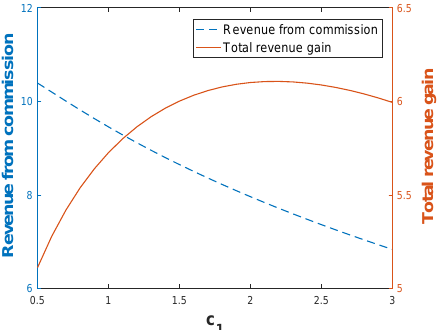
− π 0 . Revenue from commission: 1 1